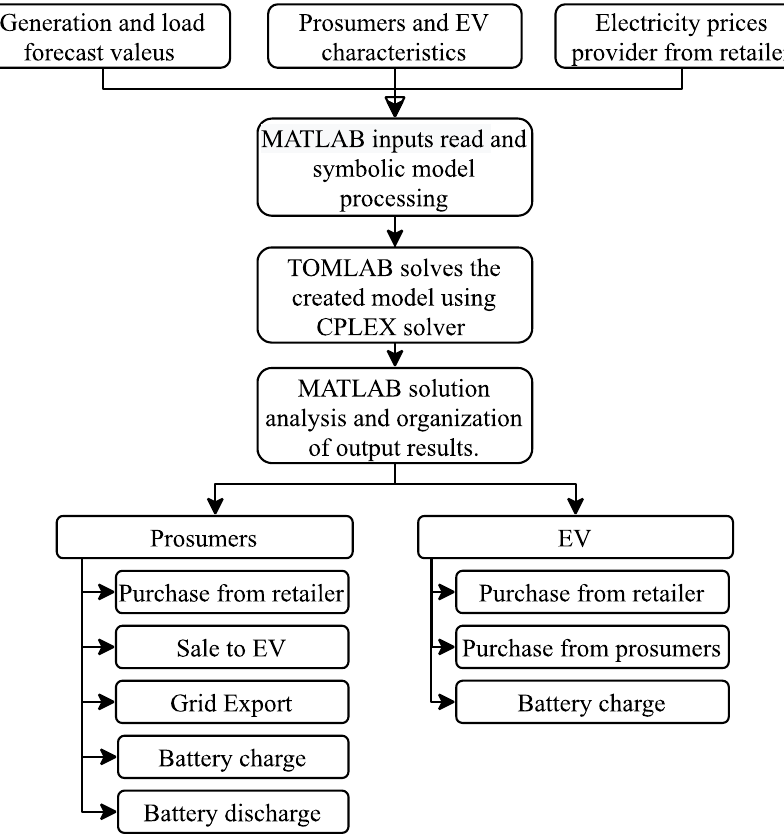
Figure 1. Methodology block diagram.